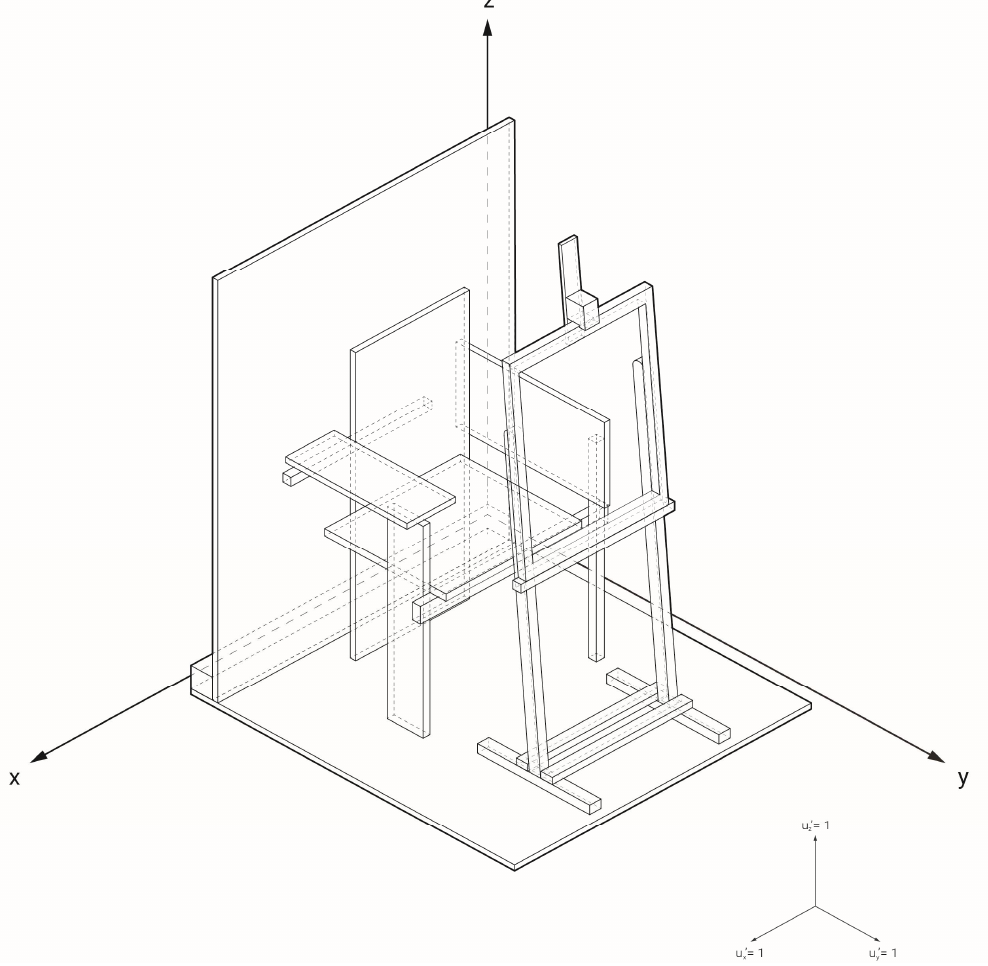
Figure 5. Maria Virgilia Manzoni, Annalisa Marchetti: “ Hypertime